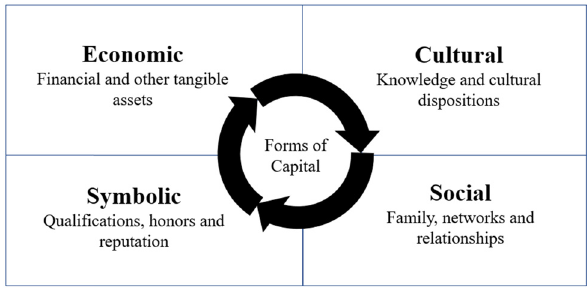
Figure 1: Bourdieu ’ s capital forms ( Harvey and MacLean 25 )